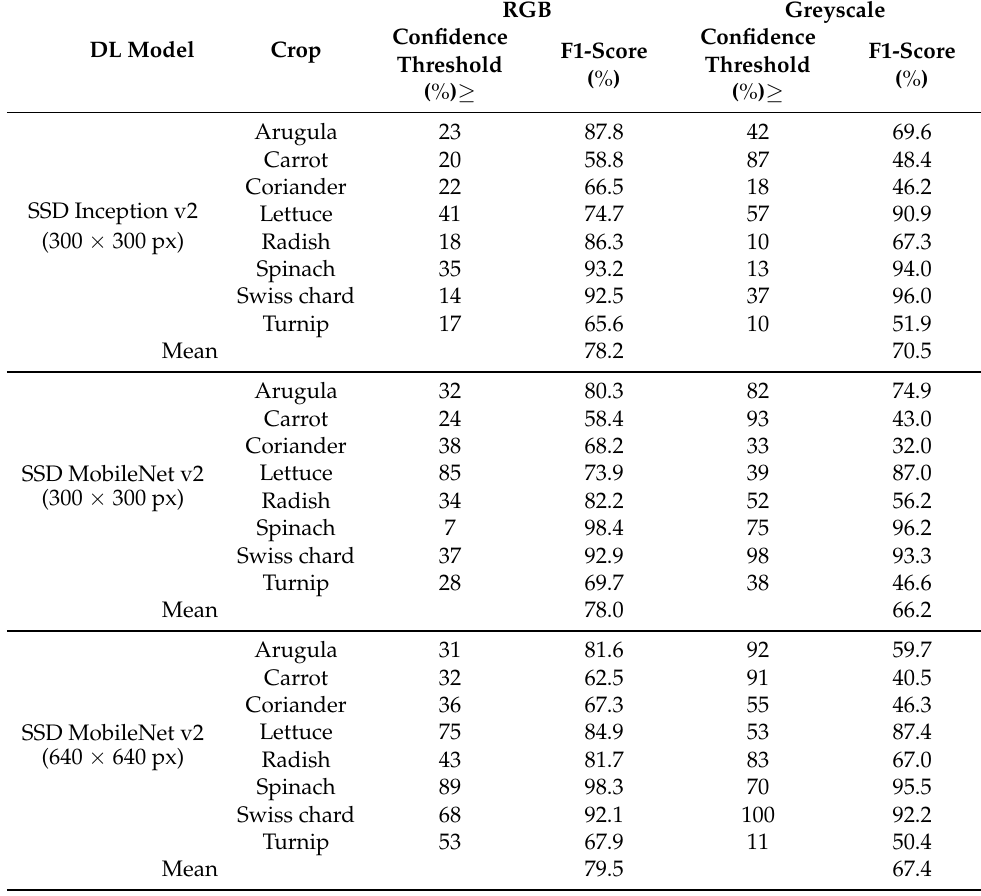
Table 6. Confidence threshold that optimises the F1-score metric for each deep learning (DL) model tested in the validation set without